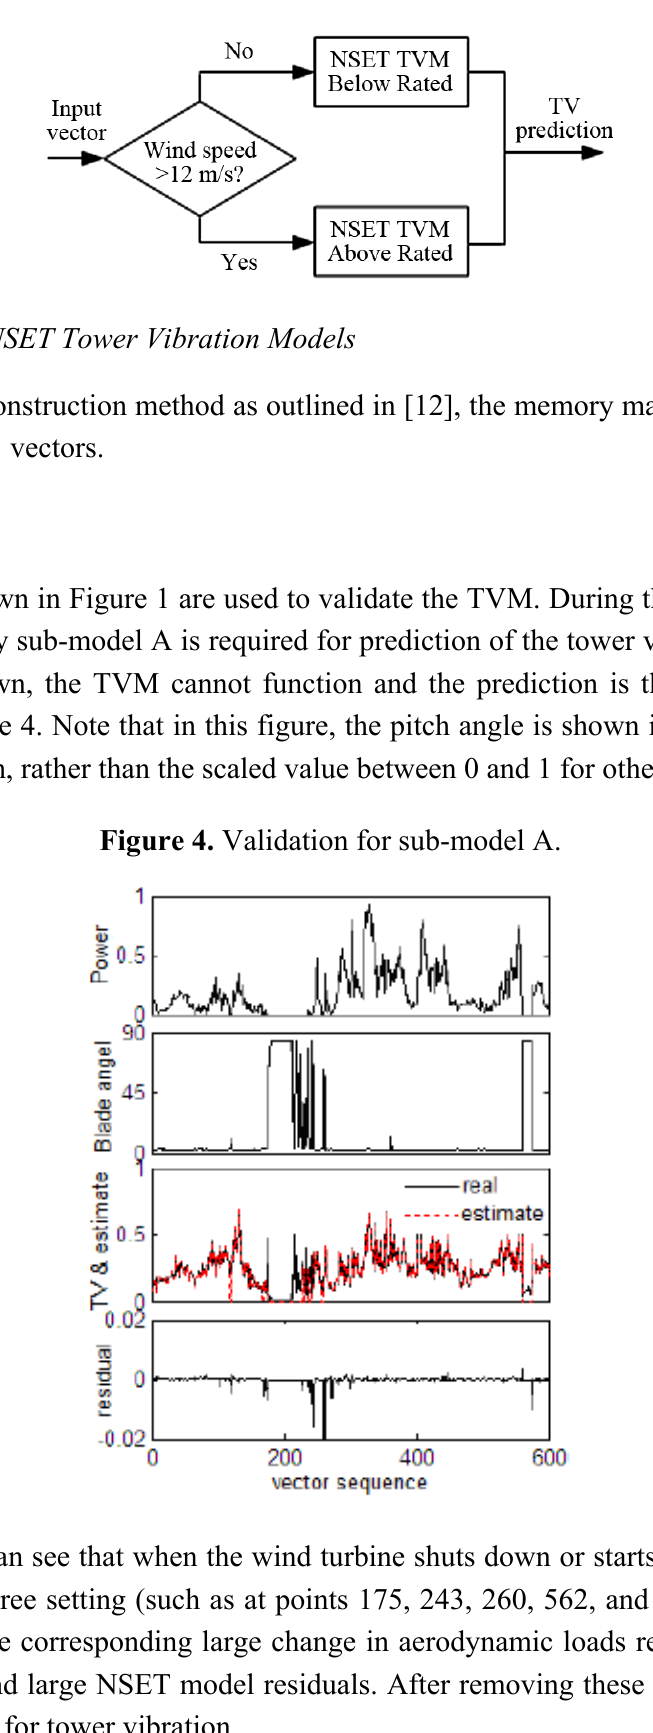
Figure 3. NSET modeling and prediction for tower vibration.